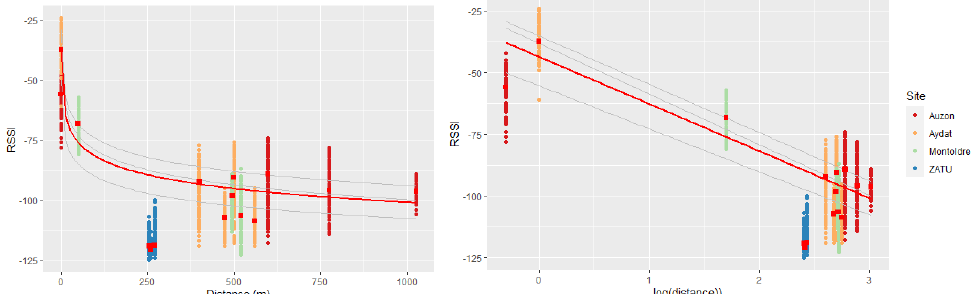
Figure 16. Statistical log-normal path-loss model (RSSI vs. Distance (m)).